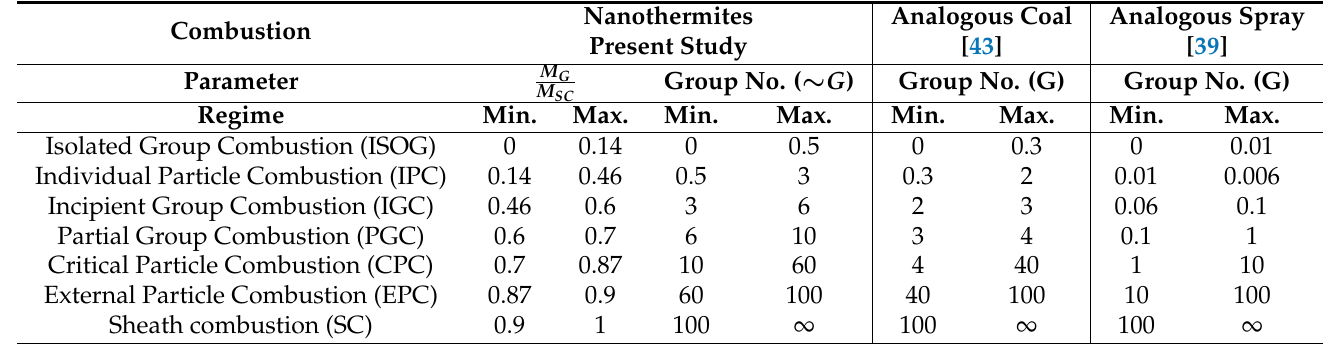
Table 3. Comparison of group number with other combustion